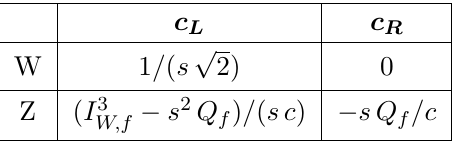
Table 1 . Weak couplings. c = cos (cid:18) W = M W =M Z , s = sin (cid:18) W